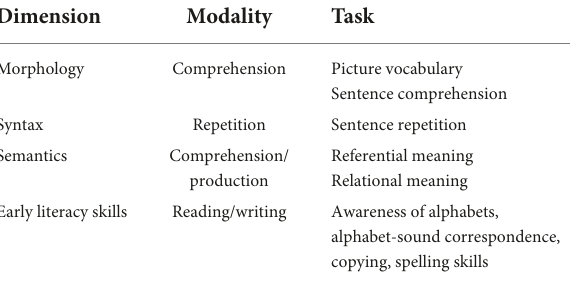
TABLE 2 Linguistics components included in the MPLAT screening test (Razak et al.,